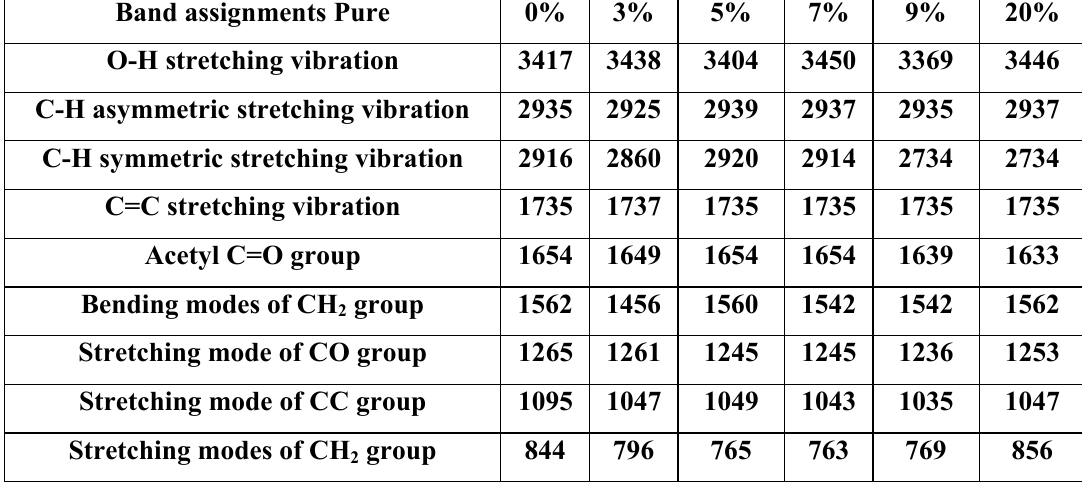
Table 1: FTIR absorption bands positions and their assignments for pure PVA and PVA/CuI polymer composites. Band assignments